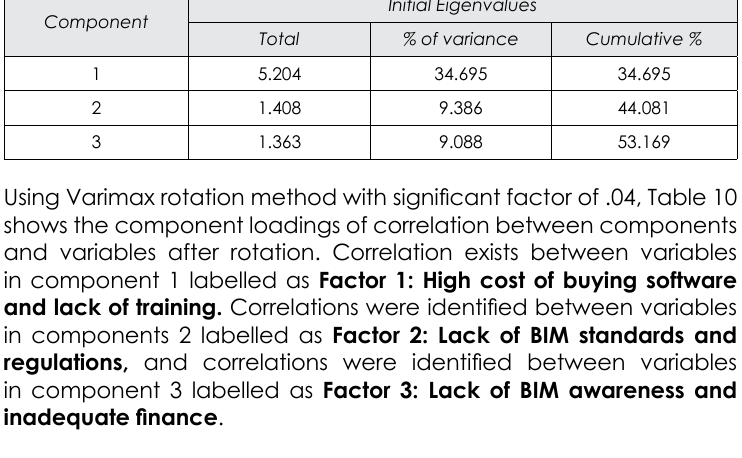
Table 10: Rotated component matrix a for BIM application barriers